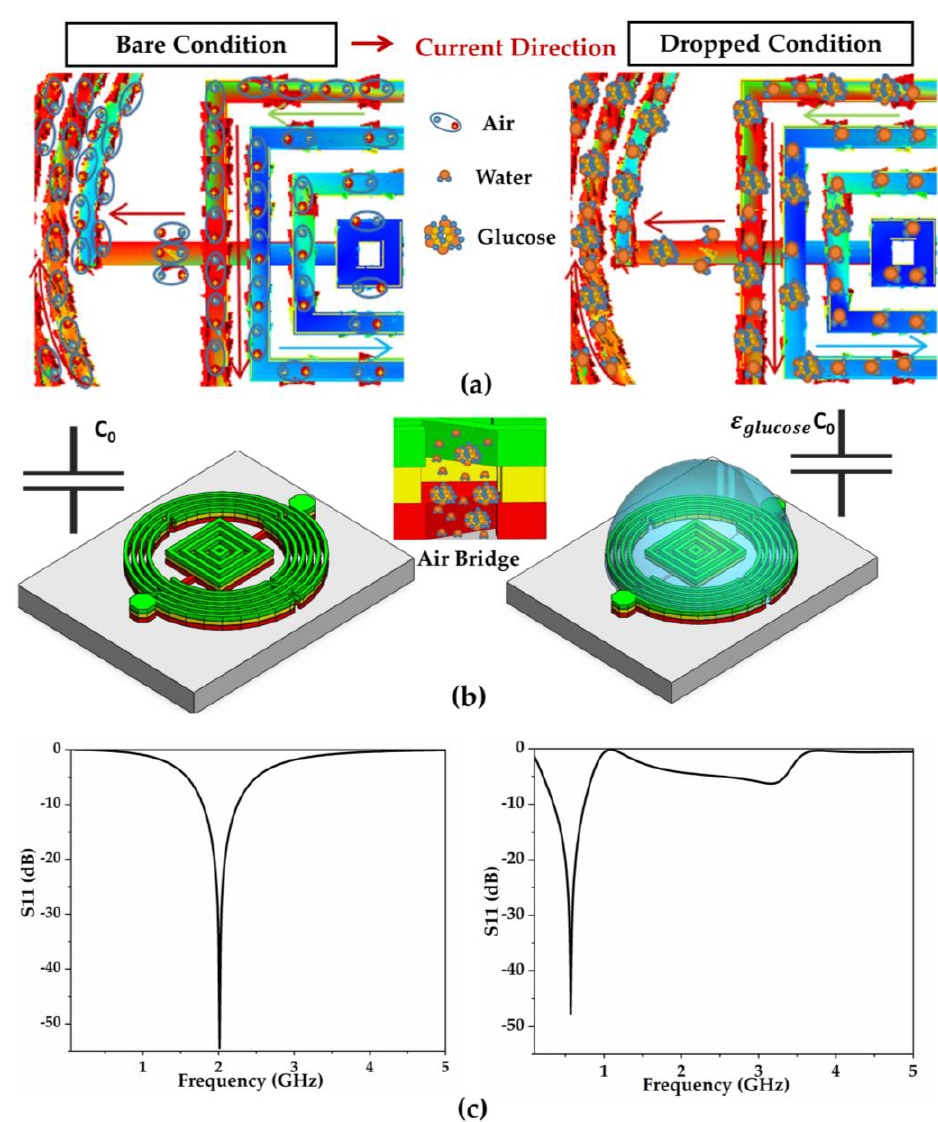
Figure 8. Comparison of bare and dropped condition. ( a ) Molecular polarization condition corresponding to current di-rection. ( b ) Corresponding equivalent capacitor. ( c ) Resonance simulation corresponding to without and with SUT.